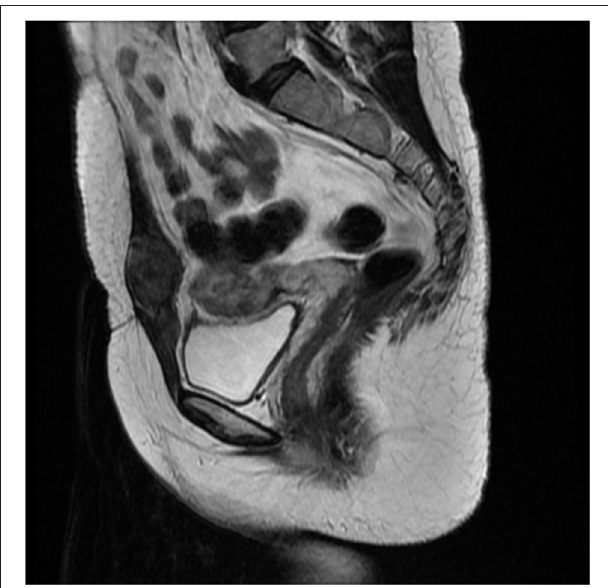
FIGURE 1 | Magnetic resonance imaging (MRI) revealed a 3 × 2.6-cm soft tissue mass in the anterior abdominal